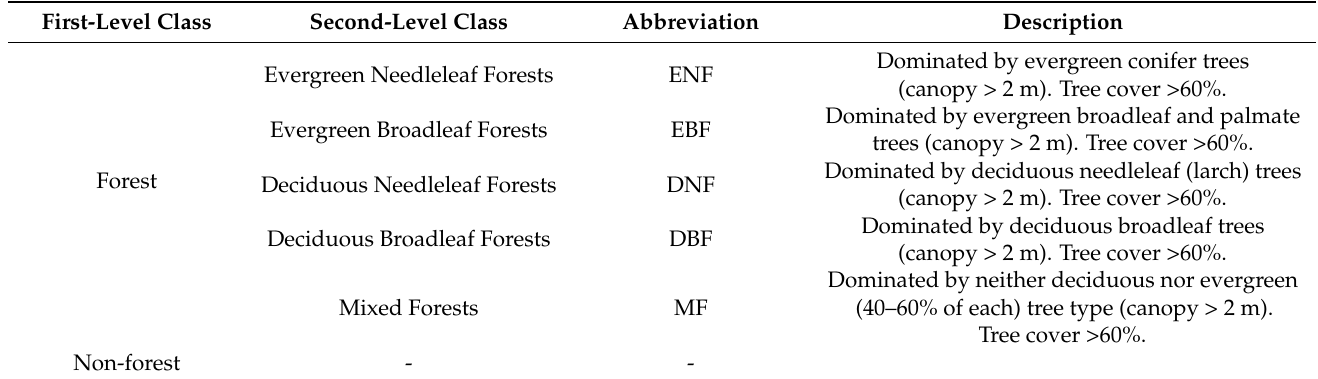
Table 2. The classification scheme of this study, and the definitions of forest types are drawn from the International Geosphere-Biosphere Program (IGBP) classification